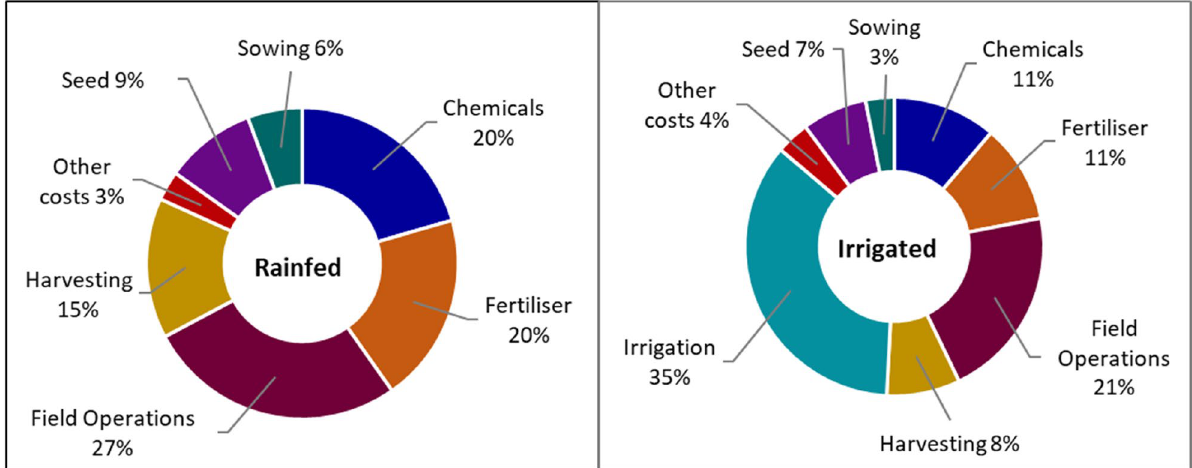
Figure 3. Average distribution of farm business variable costs for early and late maturity genotypes of durum wheat, barley, canola, chickpea and maize under irrigated and dryland conditions across four representative regions in the Australian irrigated cropping zones.